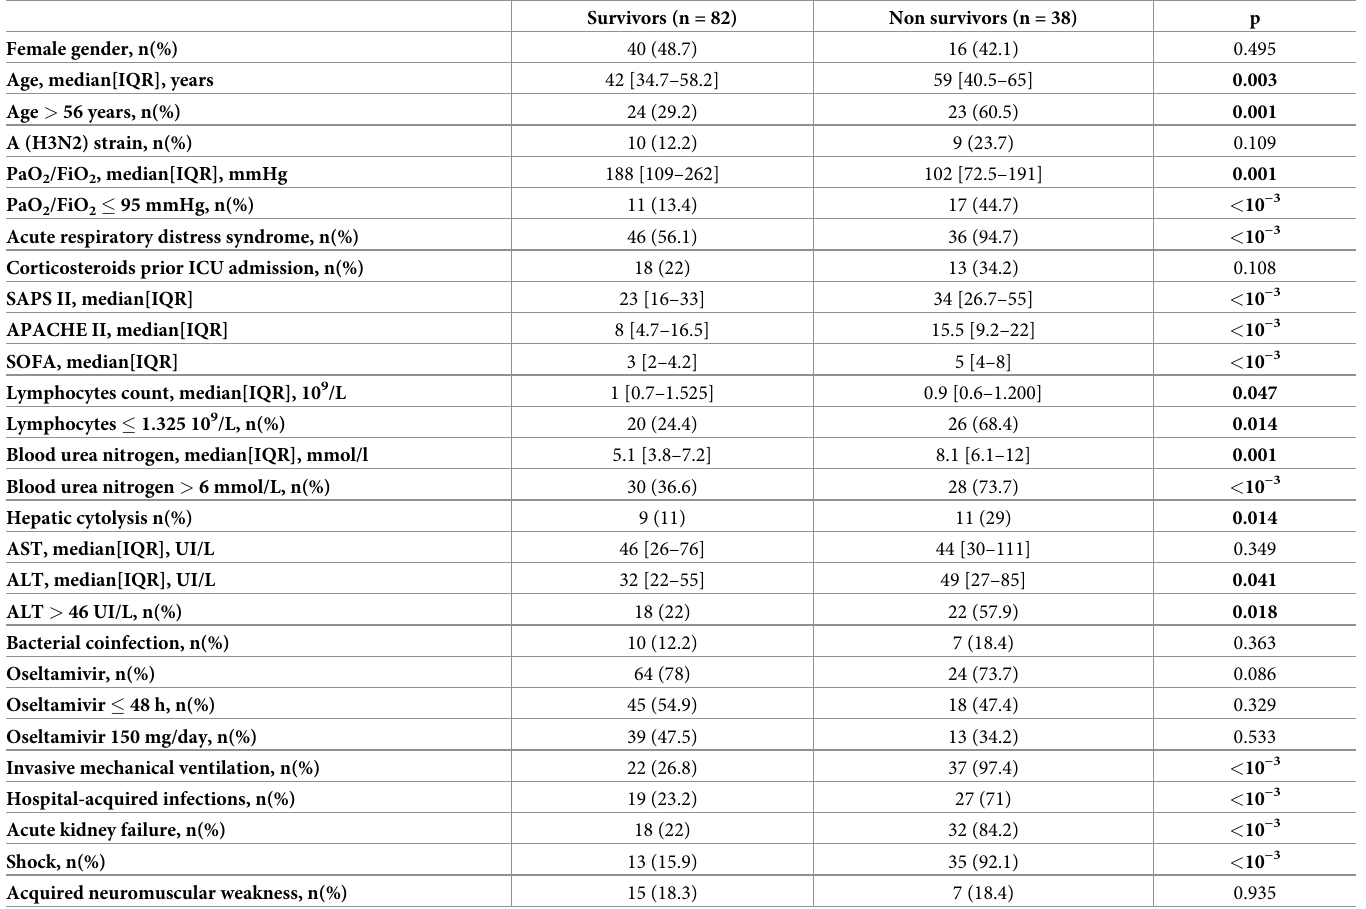
Table 4. Characteristics of survivors and non survivors among ICU patients with influenza A.